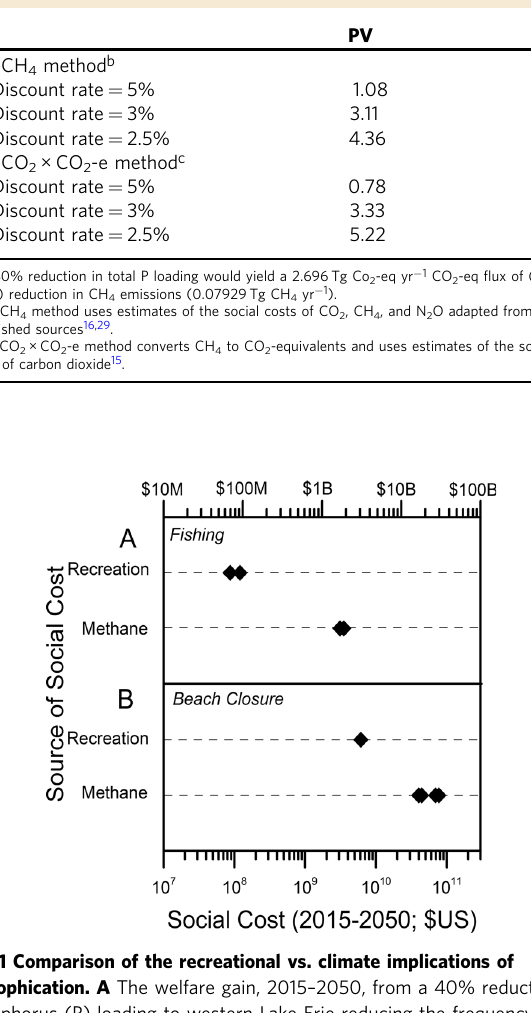
Table 2 Present value (PV) of avoided global social costs of CH 4 emissions, 2015 – 2050 (billion 2015 US$), from a 40% reduction in total P loading in the western Lake Erie basin a .